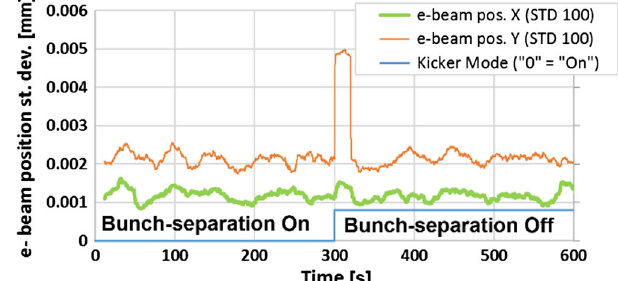
FIG. 18. Electron beam position running standard deviation of 100 consecutive pulses right before the FEL undulator section with the bunch-separation system on and off.